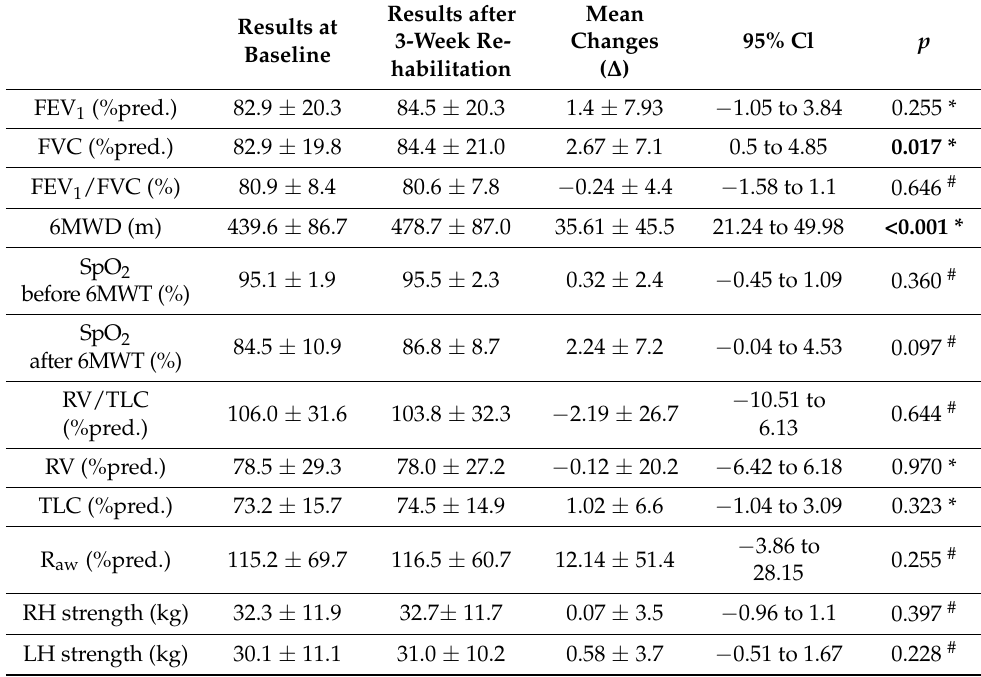
Mean Changes 95% Cl p ( ∆ )